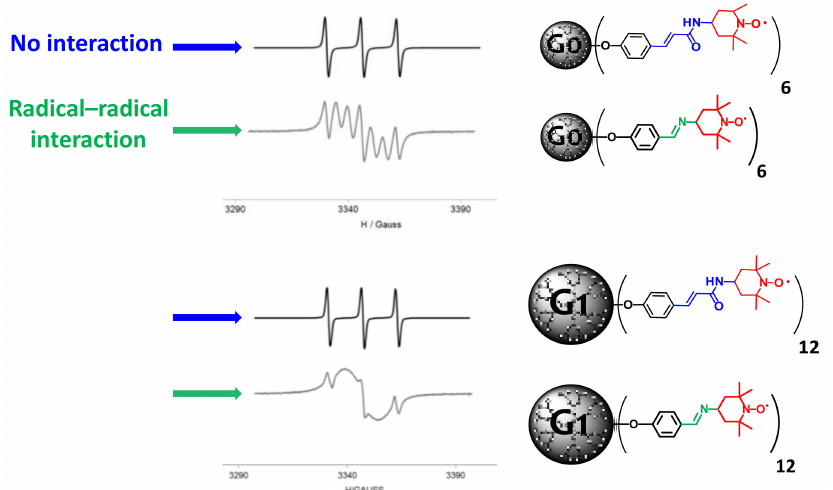
Figure 4. EPR spectra of PPH Gn-acrylamido-TEMPO and Gn-imino-TEMPO radical dendrimers, showing the different intramolecular spin–exchange interaction among radicals, depending on the linker used. Published by ChemPhysChem in 2018